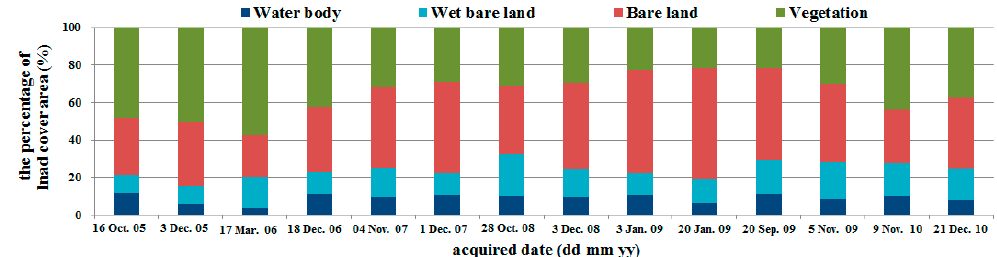
Figure 9. Land cover changes in the study area from 2005 to 2010 (model establishment).